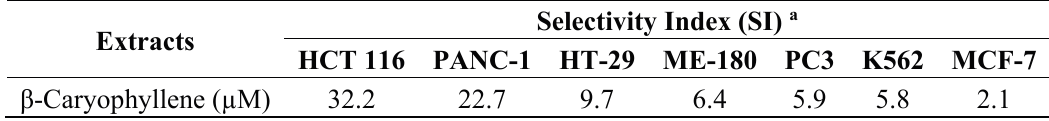
Table 4. Selectivity index of β -Caryophyllene which represents IC 50 for normal cell line/IC 50 for cancerous cell